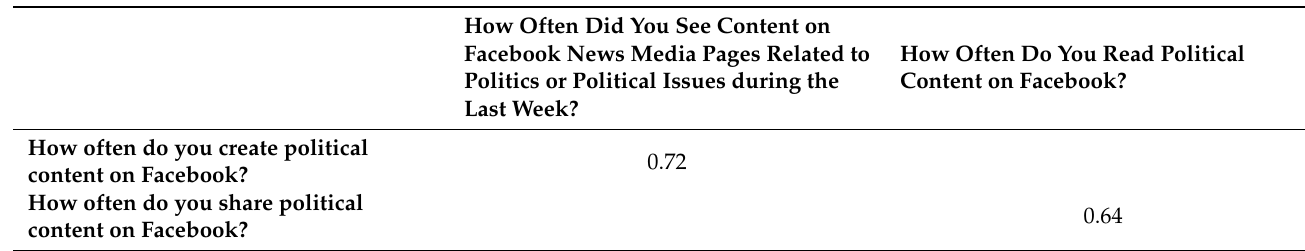
Table 5. Correlation between all actions and between specific actions.